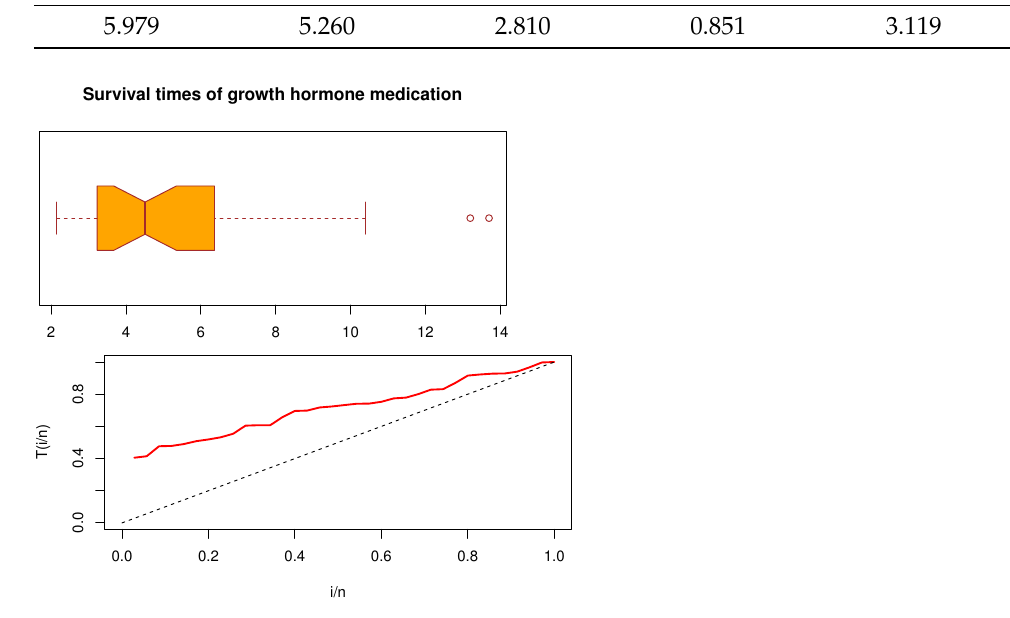
Figure 2. Box plot and TTT plot for the survival times of growth hormone medication.